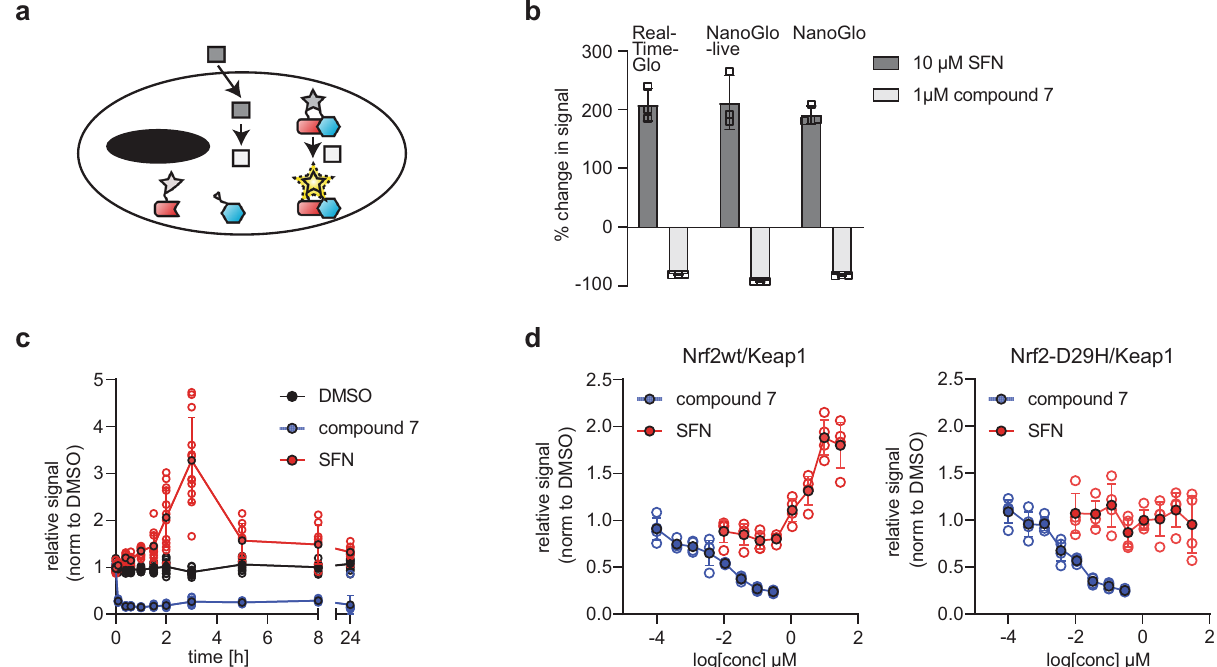
Fig. 1 Real-time detection of protein interactions in cells on the example of the Nrf2-Keap1 interaction. a Schematic of RT-Bind principle: cells expressing the protein of interests (red/blue cartoon) tagged with either SmB or LgB of modi fi ed NanoLuciferase (gray star), are incubated with a long- lived pro-substrate for NanoLuciferase (dark gray box), which is continuously metabolized by the cells to the NanoLuciferase-compatible substrate (light gray box). Interaction of the proteins of interest leads to complementation of the NanoBit enzyme and, in presence of the metabolized substrate, to luminescence. b Relative luminescence signal after 4 h treatment with 10 µ M Sulforaphane or 1 µ M compound 7 in HEK293T-SmB-Nrf2/Keap1-LgB cells (mean ± s.d., n = 3 wells each, representative experiment) as detected by the use of the indicated luciferase substrates. c Relative luminescence signal in HEK293T-SmB-Nrf2/Keap1-LgB cells detected by RT-bind by measuring the same plate at the indicated time points after treatment with 10 µ M Sulforaphane or 1 µ M compound 7 (mean ± s.d., n = 12 wells each, representative experiment). Data were normalized to the pre-treatment luminescence signal for each well and subsequently normalized to the control treatment (DMSO). d Relative luminescence signal in HEK293T-SmB-Nrf2/Keap1-LgB or HEK293T-SmB-Nrf2-D29H/Keap1-LgB cells detected by RT-Bind 4 h after treatment with 10 µ M Sulforaphane or 1 µ M compound 7 (mean ± s.d., n = 4 wells each, representative experiment). Data were normalized to the control (DMSO) treated